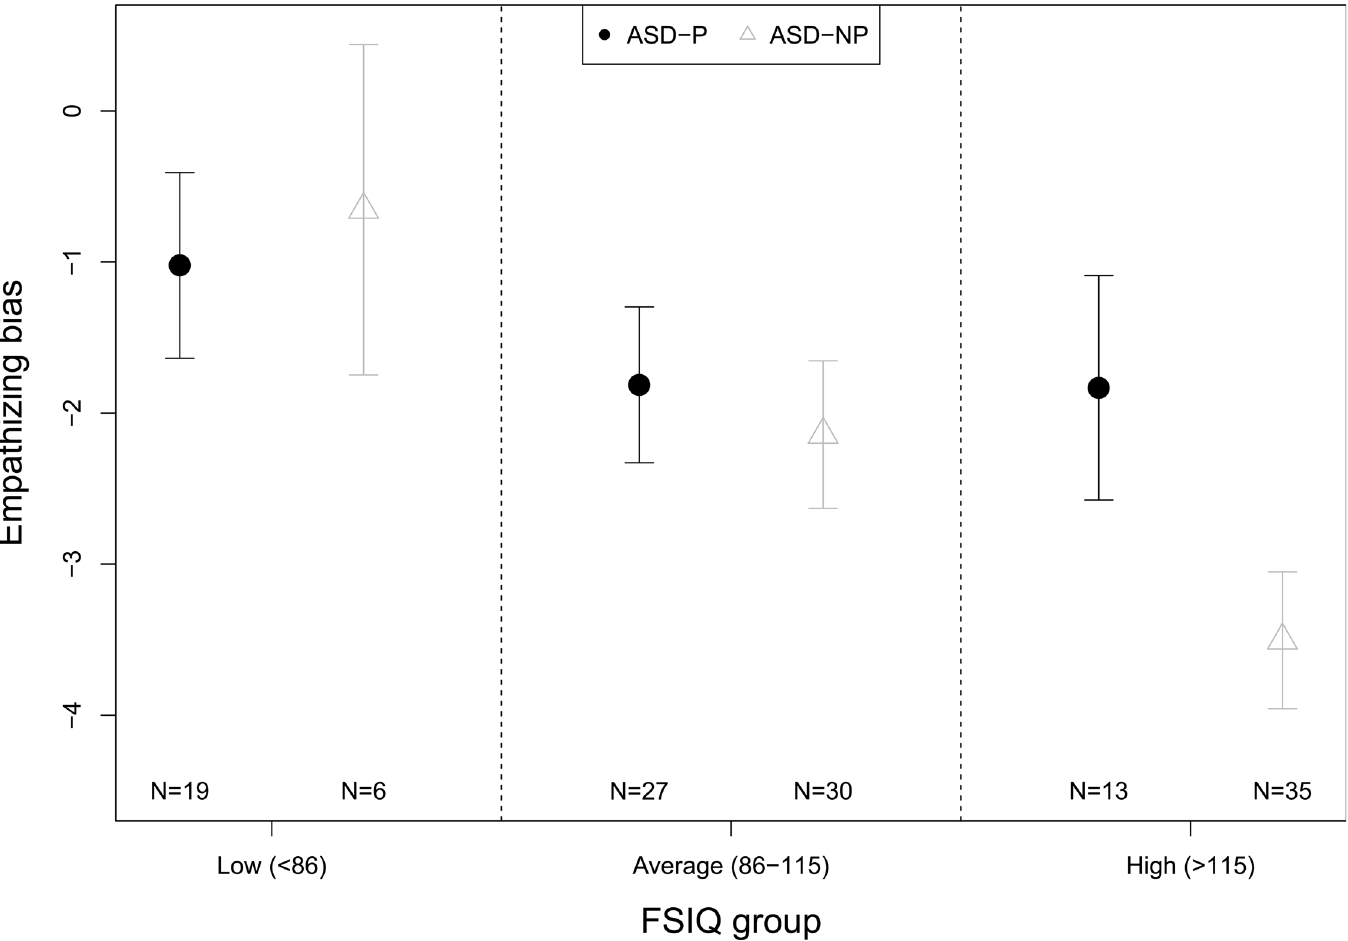
Fig 2. Fitted empathizing bias (EB) means. This figure shows fitted EB means with 95% confidence intervals, within each group at each level of the categorized full-scale